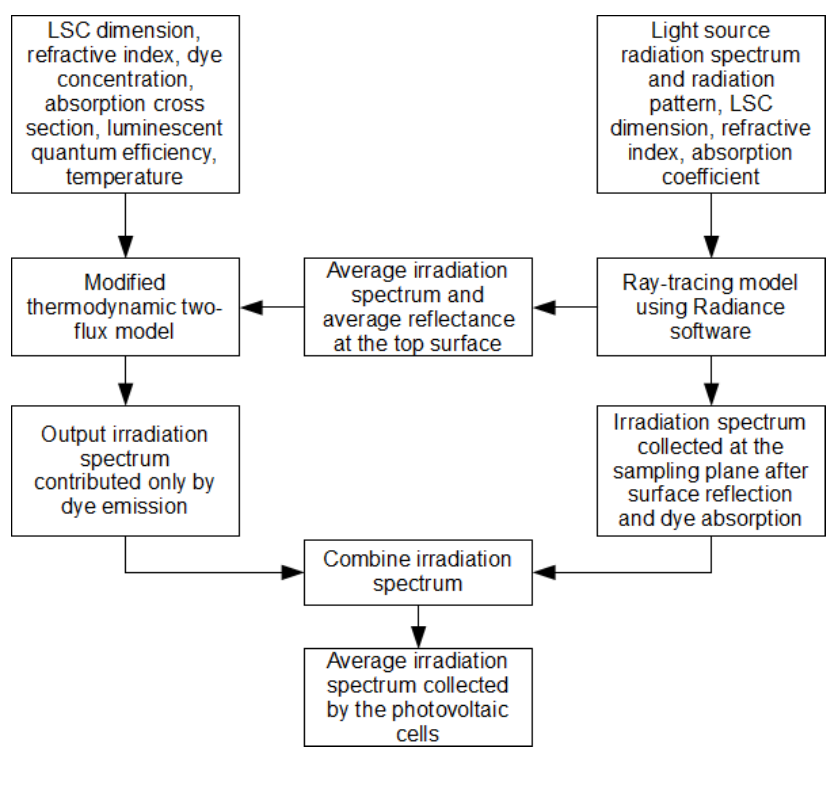
Figure 2. Hybrid simulation program flow